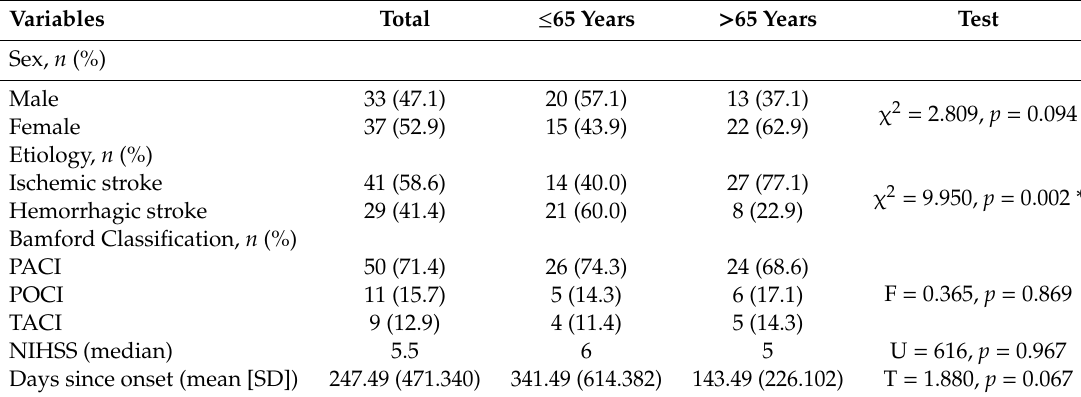
Table 1. Characteristics of the study population and comparison between patients ≤ 65 and > 65 years old.